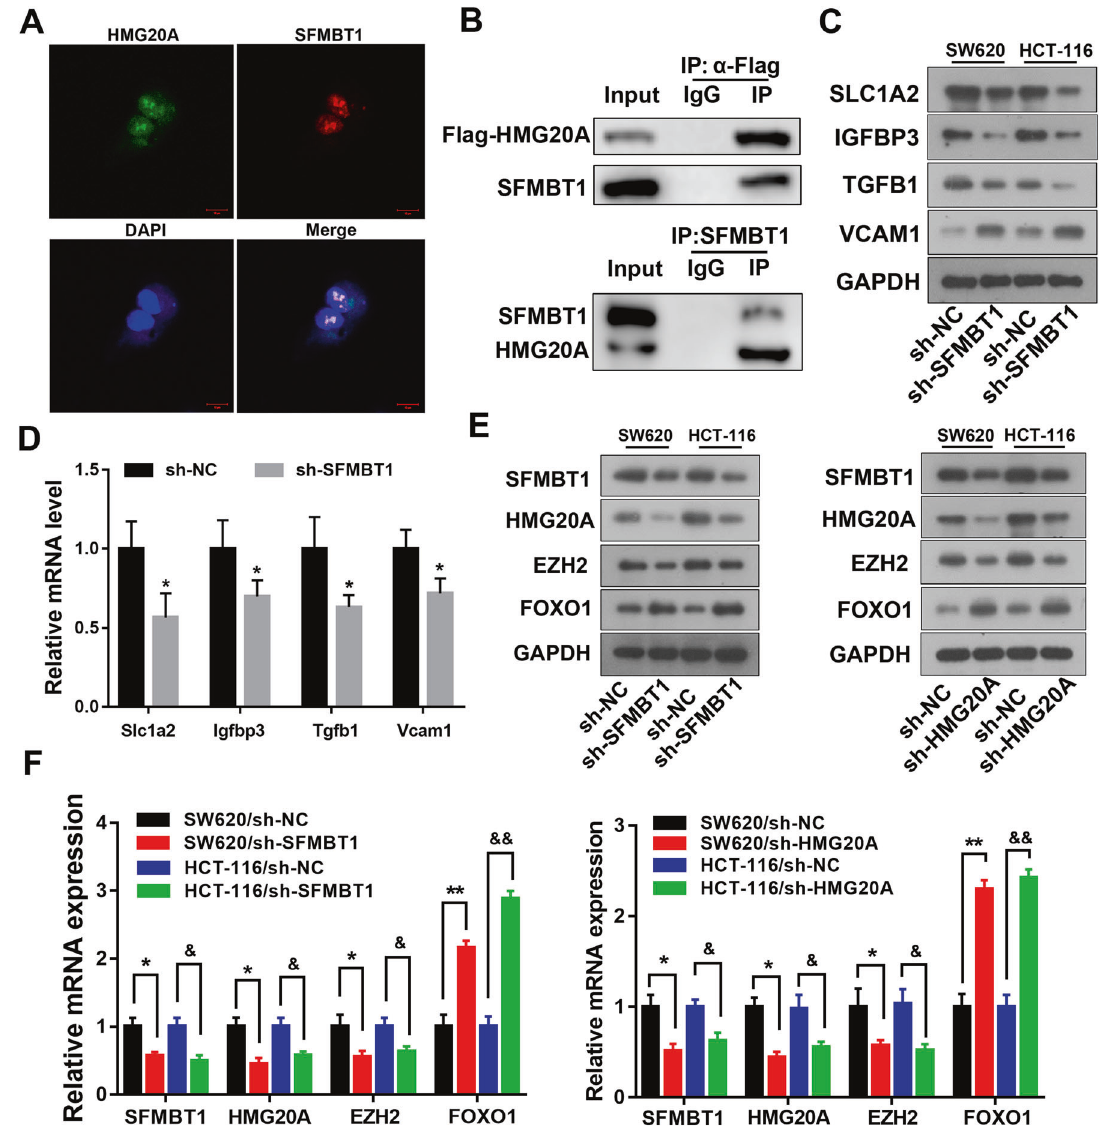
Fig. 6 HMG20A and SFMBT1 interact in vitro. A After 48 h transfection, the co-localization (yellow) of HMG20A (green) and SFMBT1 (red) were analyzed using fl uorescent microscopy. Cell nuclei were stained by DAPI (blue). B Interaction of HMG20A and SFMBT1 in cells veri fi ed by co-immunoprecipitation. C , D Western blot analysis ( C ) and qRT-PCR ( D ) detect HMG20A protein and mRNA of downstream gene and protein after SFMBT1 knockdown. E , F Western blot and qRT-PCR analysis SFMBT1, HMG20A, EZH2 and FOXO1 protein ( E ) and mRNA levels ( F ) after SFMBT1 or HMG20A knockdown in SW620 and HCT-116 cells. * P < 0.05, ** P < 0.01, & P < 0.05, && P <